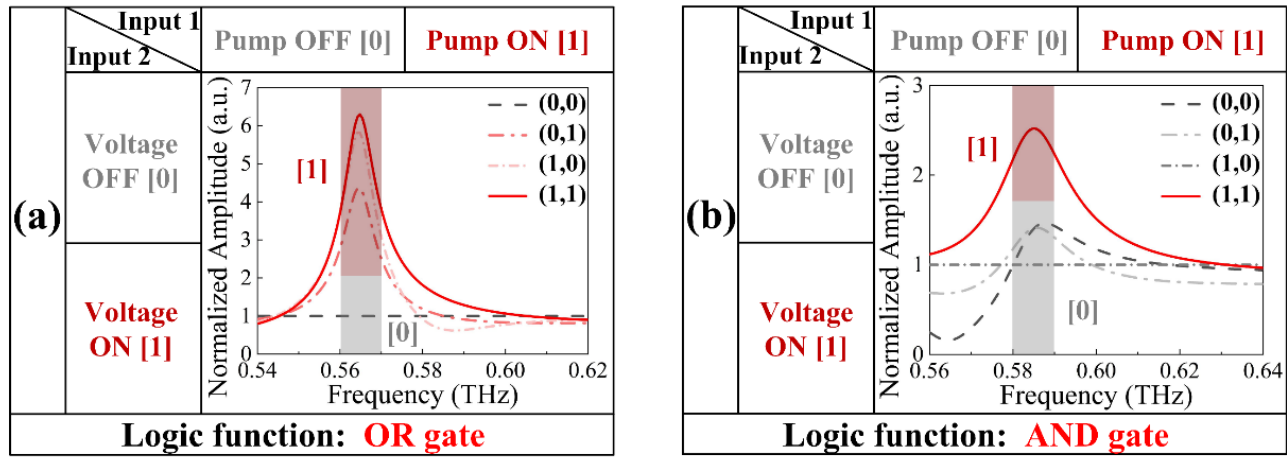
Figure 7. The dual-stimulus-controlled hybrid metasurface is functionalized as a logic ( a ) OR gate at 0.56–0.57 THz and ( b ) AND gate at 0.58–0.59 THz.